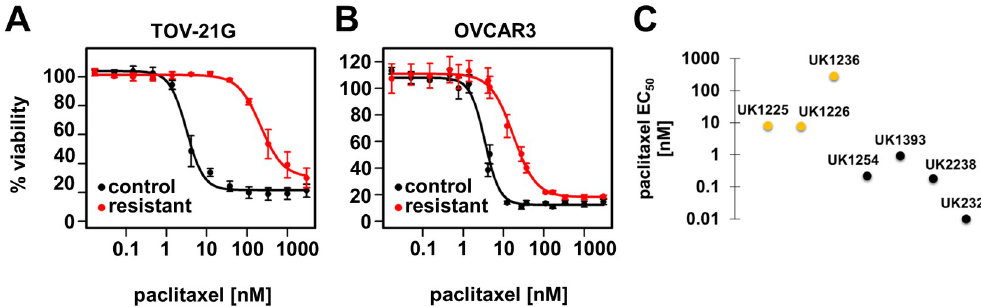
Fig 1. Ovarian cancer cell lines exhibit varied responses to paclitaxel treatment. Paclitaxel-resistant (PacR) and parental control ovarian cancer cell lines, TOV-21G and OVCAR3, were treated with serially diluted doses of paclitaxel for 96 hours in vitro . Cell viability is displayed at each concentration tested relative to untreated cells for the control (black) and PacR (red) cell lines of (A) TOV-21G and (B) OVCAR3 cells. Dose response curves were fit to the data and IC 50 values were calculated using four-parameter log-logistic models. (C) Ovarian tumor organoid cell lines’ paclitaxel EC 50 values. Resistant lines are shown in gold and sensitive lines are shown in black.